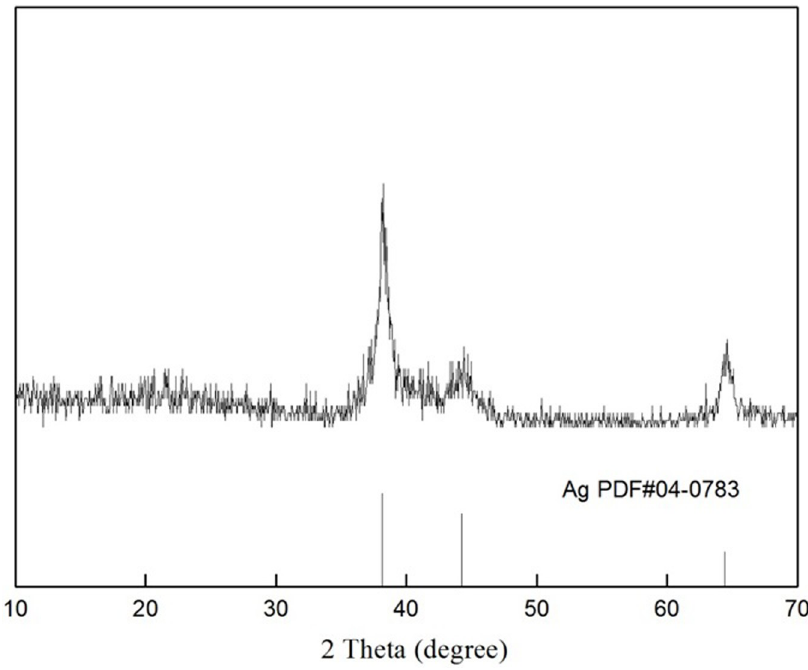
Fig 4. XRD patterns of synthesized Z . officinale AgNPs.